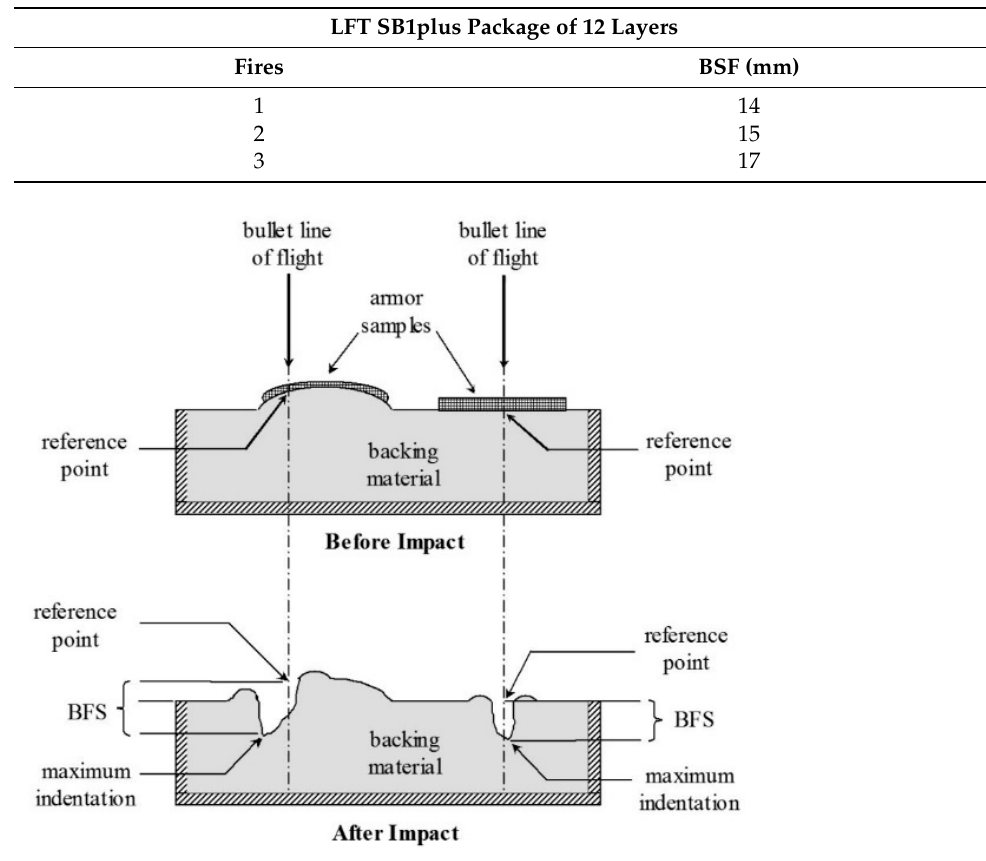
Figure 16. Measuring BFS in agreement with Ballistic Resistance of Body Armor, NIJ Standard- 0101.06 [23].